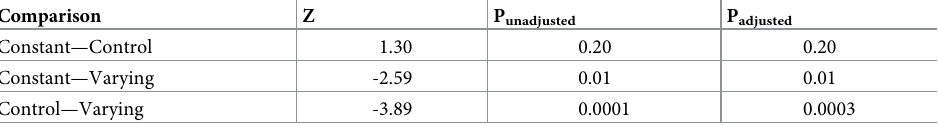
Table 3. Statistical test comparing the spread of vanishing bearings (circular analog of homoscedasticity) for each pair of conditions in Release 1 (analysis from [22]). Comparison Z P unadjusted P adjusted 1.30 0.20 Constant—Varying -2.59 0.01 0.01 Control—Varying -3.89 0.0001 0.0003 Spread is calculated by the absolute value of deviation angles from each measurement with the mean vector for that condition. The statistical test used was the Kruskal-Wallis multiple comparison (using R program Kruskal.test; p- values adjusted with the Benjamini-Hochberg method [23] using R program dunnTest). The p-values indicate the probability that the two groups share the same spread of vanishing